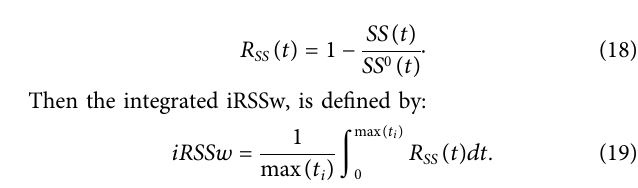
Frontiers in Big Data |